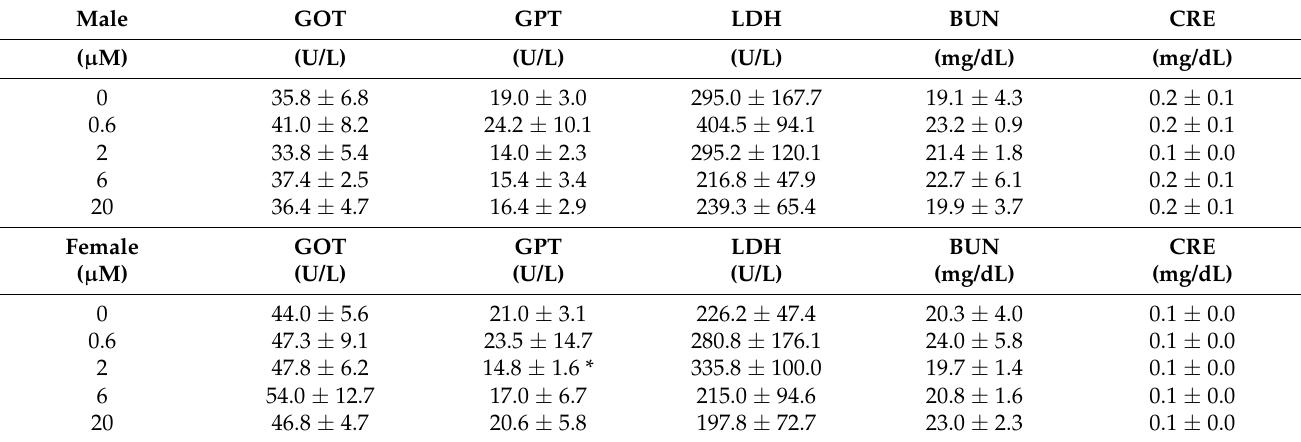
Table 4. Serum biochemistry changes in liver and renal function of ICR mice feeding with FANC for 14